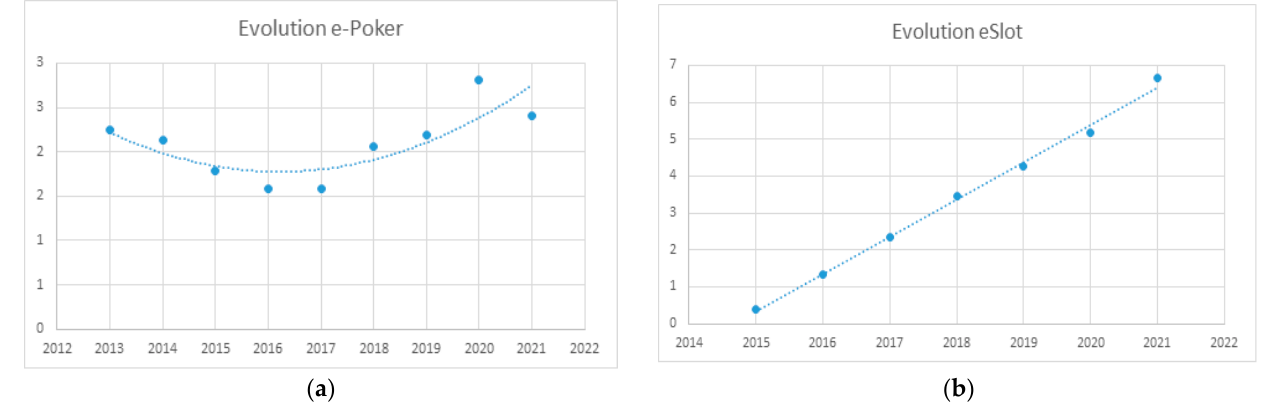
Figure 5. ( a ) Evolution of online poker; ( b ) Evolution of online slot-game spending. Online spending on sports betting has exhibited constant growth since its legalization. devised.